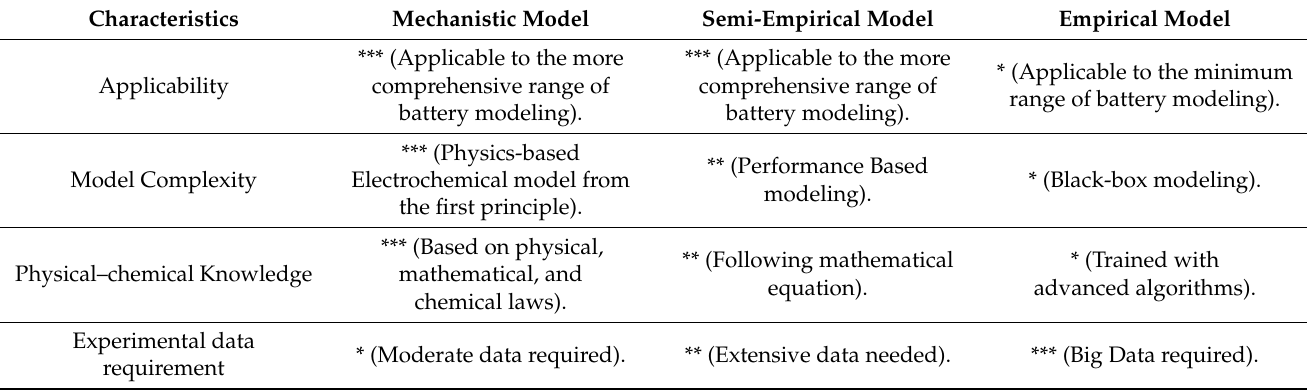
Table 4. Comparison of the different